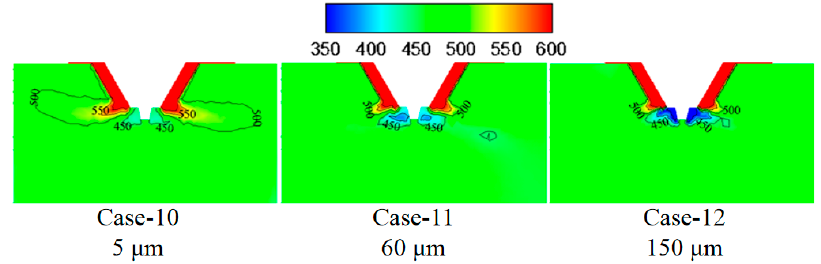
Figure 17. Temperature under different droplet sizes (K). Figure 16. Turbulence kinetic energy under different droplet sizes (m 2 /s 2 ).